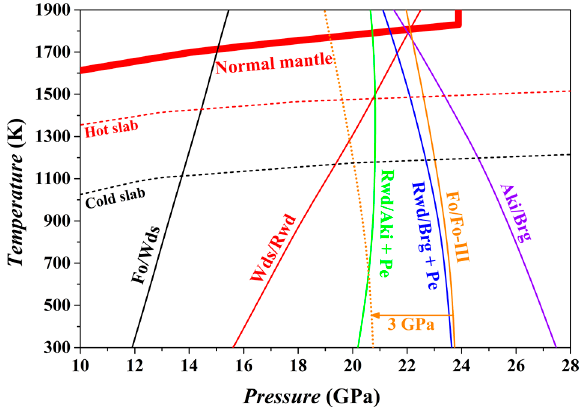
Figure 14. Calculated P - T boundaries for the Fo/Wds, Wds/Rwd, Rwd/Aki + Pe, Rwd/Brg + Pe, Aki/Brg and Fo/Fo-III reactions at 10–28 GPa and 300–1900 K. The P - T profile of the cold slab or hot slab is sketched according to Thompson [93], while that of the normal mantle is from Anderson [94]. All data used in the calculation are from our theoretical simulation with the GGA method. According to Wentzcovitch et al. [66], all these phase boundaries at T < ~1500 K are potentially overestimated by ~3 GPa because of the used GGA method, as indicated for the Fo/Fo-III phase boundary by the arrow.